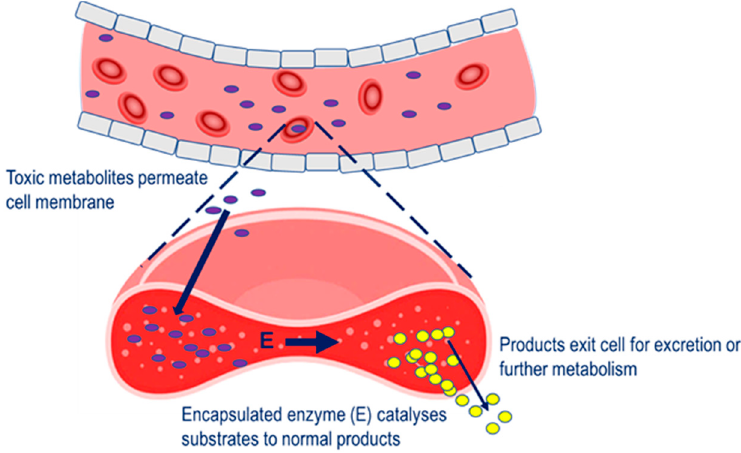
Figure 1. Strategy for the removal of pathological metabolites from the circulation. Pathological metabolites in the blood enter the erythrocyte carrier, to undergo metabolism by the encapsulated enzyme (E).